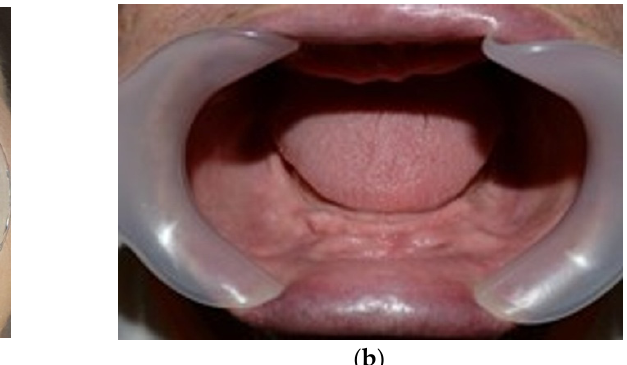
Figure 2. ( a ) Preliminary cast and final impression of a V-shaped maxillary prosthetic field, with high retentive ridges, deep palatal vault, retentive tuberosity, with flabby mucosa; ( b ) detail of the upper jaw impression recorded with two low viscosity materials in two stages. The tuberosity impression was made in the resting position, without compression, by brushing the material on its surface.